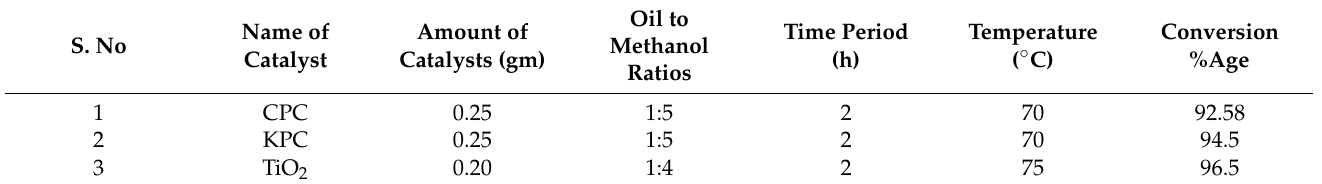
Table 1. Influence of three different catalysts on biodiesel “yield” of Prunus aitchisonii seed oil (PASO).